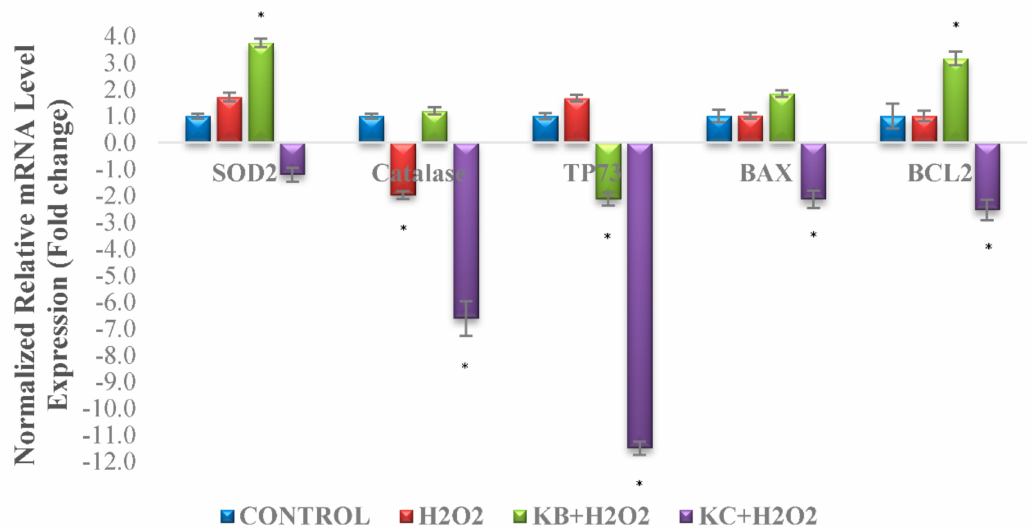
Figure 8. Expression levels of the superoxide dismutase (SOD) 2, catalase, Tp73, Bax, and Bcl-2 genes in SH-SY5Y cells. mRNA levels of SOD2, catalase, Tp73, Bax, and Bcl-2 genes following treatment with 10 mg/mL Kefir B and Kefir C for 48 h and subsequent treatment with 190 µ M H 2 O 2 for 24 h, in comparison to untreated and 190 µ M H 2 O 2 treated